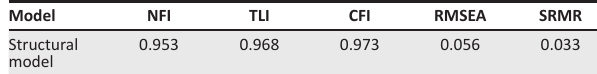
TABLE 6: Goodness-of-fit indices for the structural model.